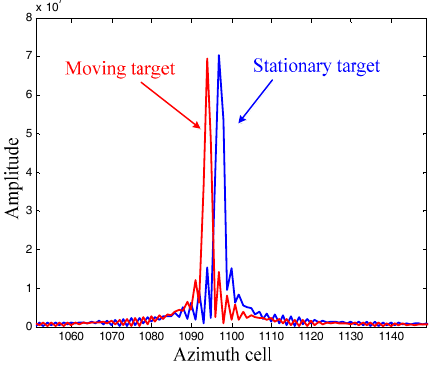
Figure 3. Azimuth localization comparison.